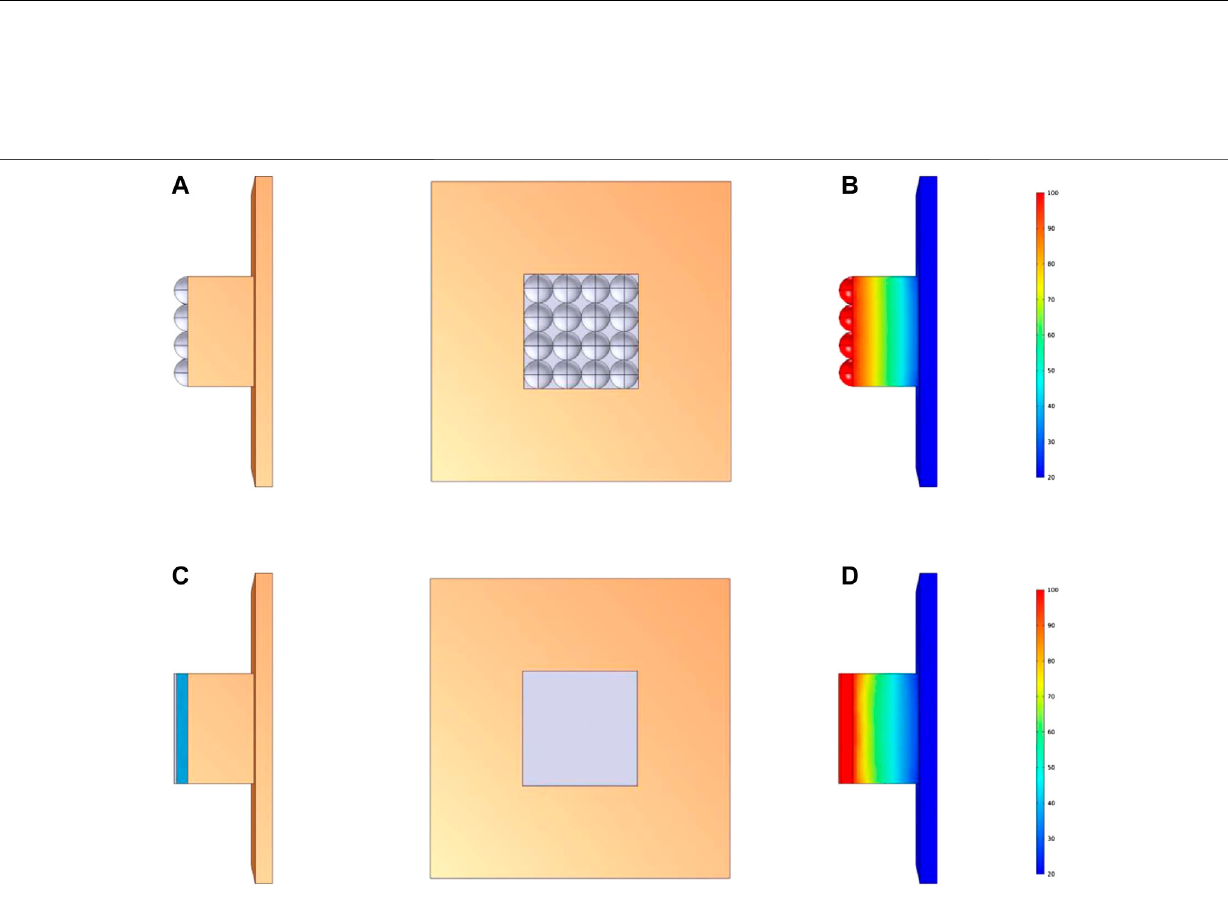
Frontiers in Energy Research |